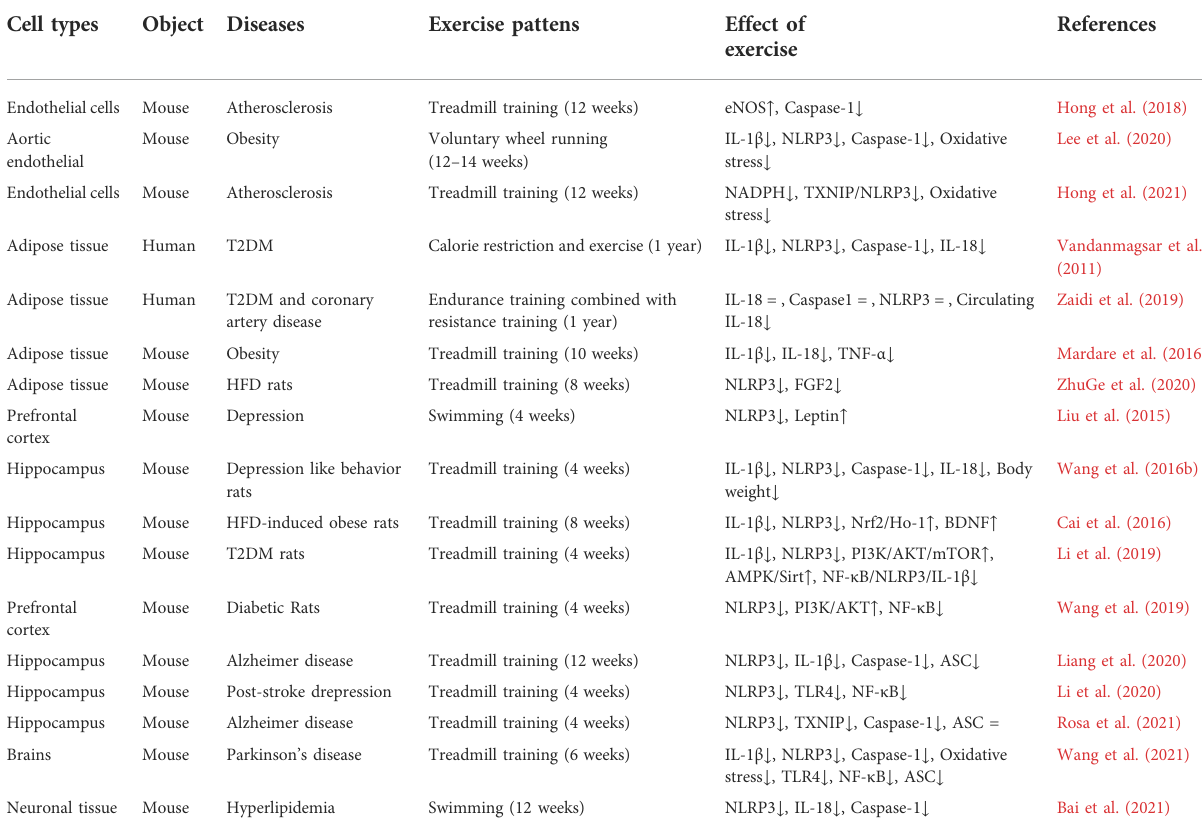
TABLE 1 Effects of aerobic exercise on pyroptosis-related factors in different